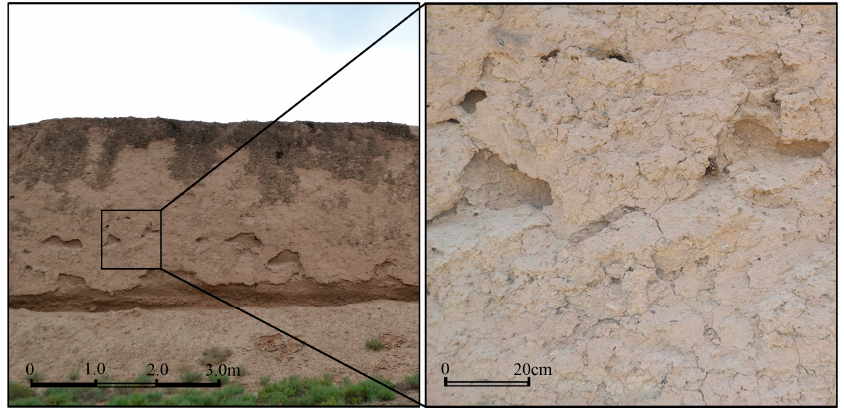
Figure 1. Deterioration in earthen sites of the Ming Dynasty Great Wall in Yongchang County, Gansu Province,